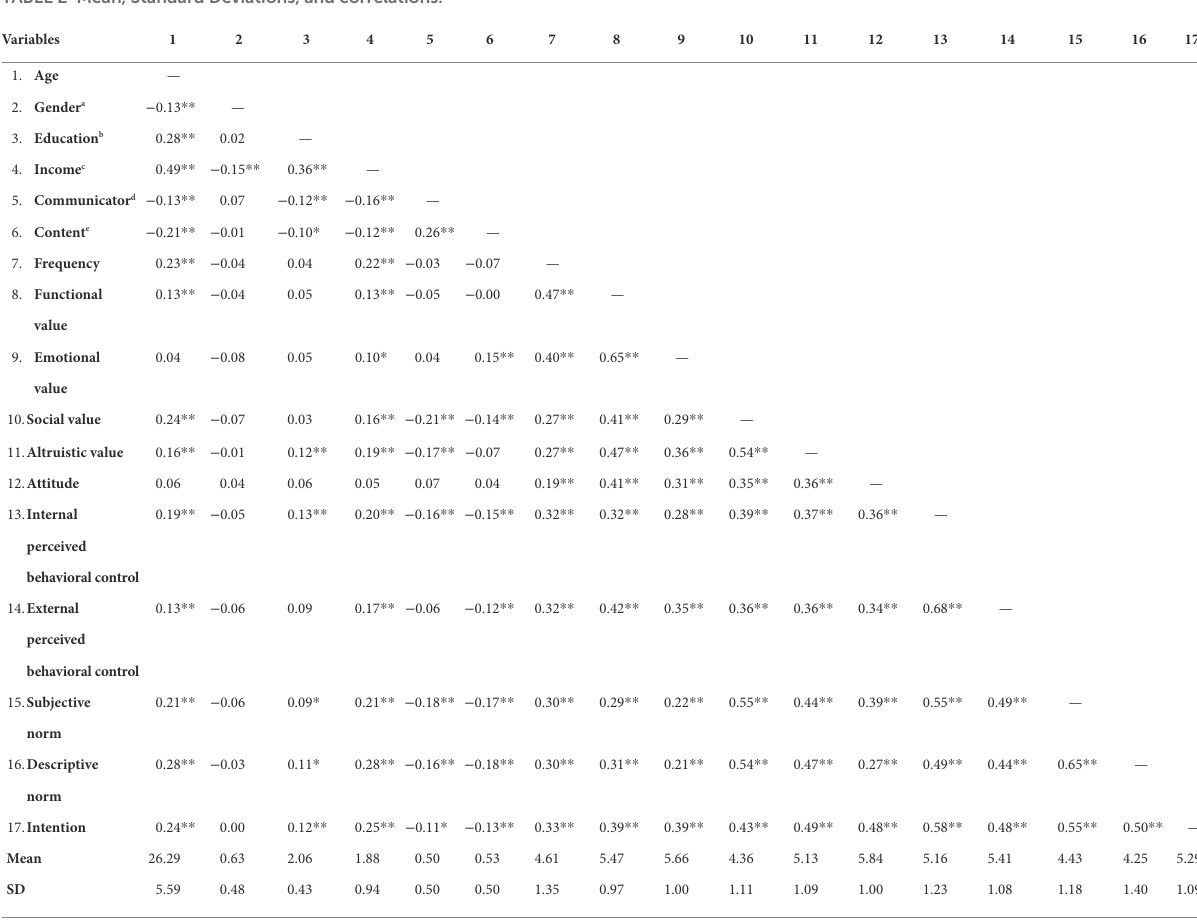
TABLE 2 Mean, Standard Deviations, and